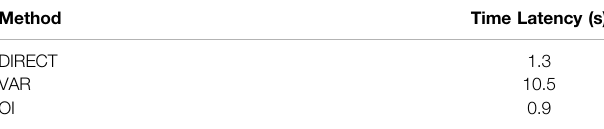
TABLE 6 | Time latency comparison of different wind retrieval